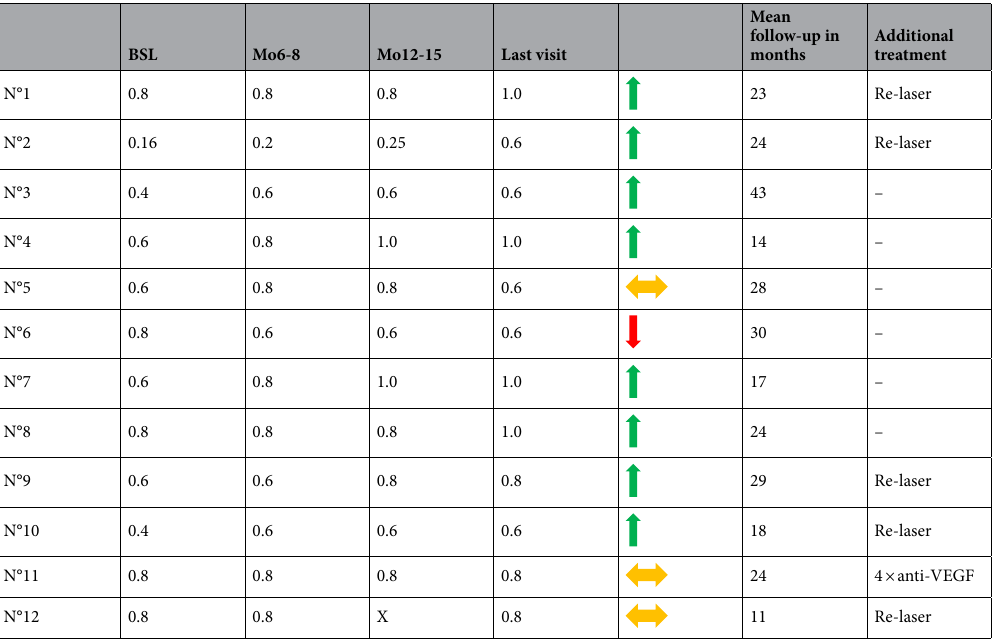
Table 1. Overview of best-corrected visual acuity (BCVA) results in Snellen decimals, the individual follow-up time in months and the re-treatments required during the follow-up period of all